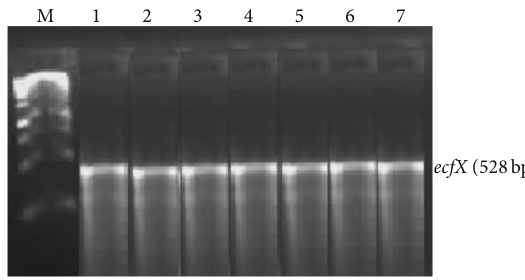
Figure 3: Image of a composite agarose (1% w/v) gel depicting genomic DNA extracted from Pseudomonas species. Lane M (1kb DNA Ladder); Lane 1–7 ecfX gene fragments from Pseudomonas species isolated from different